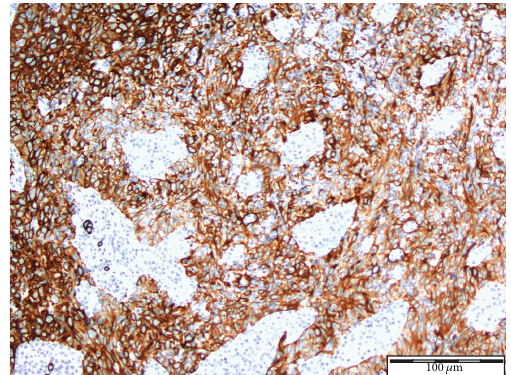
Figure 4: Lymphoepithelioma of urinary bladder-immunohisto- chemical staining for CK7. The neoplastic cells showing posi- tive staining with CK7 in a background of inflammatory cells × 10 magnification reproduced from [3] (http://dx.doi.org/10.7707/ hmj.v6i3.245) with permission from Hamdan Medical Journal